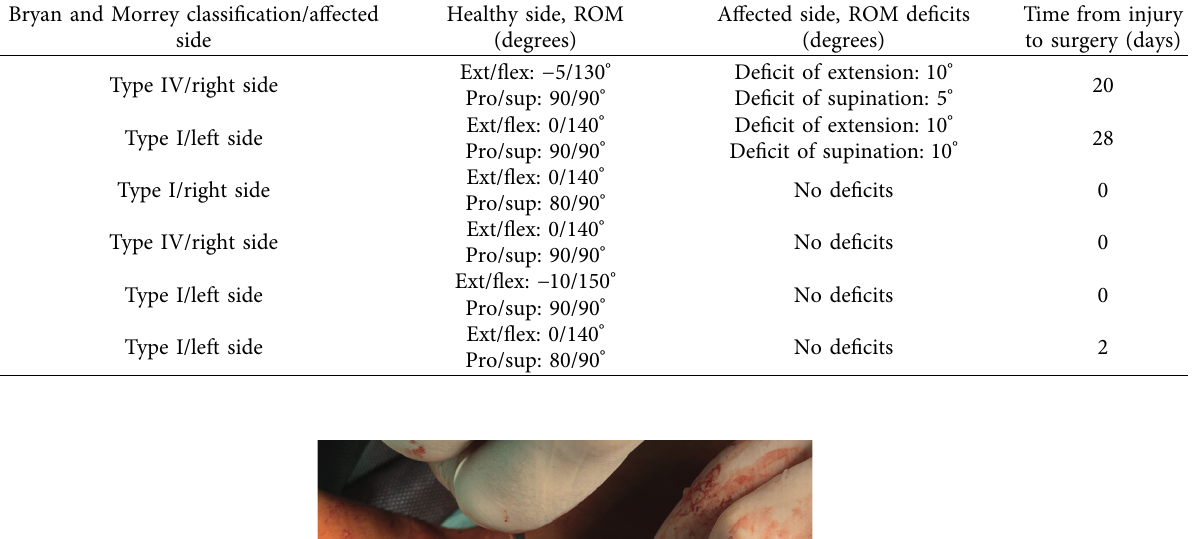
Table 2: Operated elbow range of motion in relation to the healthy side.